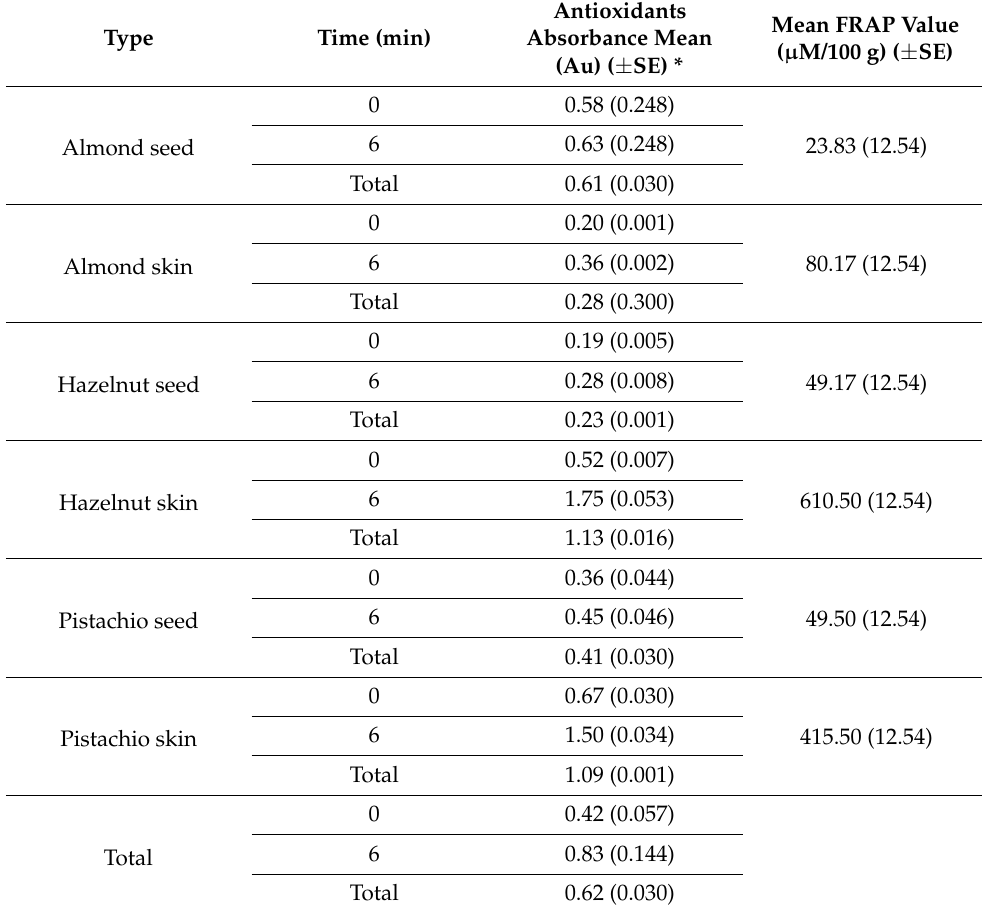
Table 1. Variation in antioxidant absorbance at 593 nm of almond, hazelnut, and pistachio seeds and skins at 0 and 6 min, and the mean FRAP